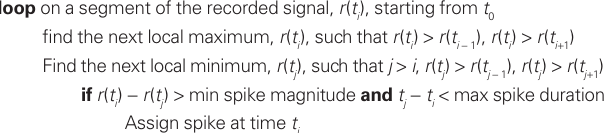
), starting from t i 0 ), such that r ( t ) > r ( t ), r ( t ) > r ( t ) i i i − 1 i i + 1 ), such that j > i , r ( t ) > r ( t ), r ( t ) > r ( t j j j − 1 j j + 1